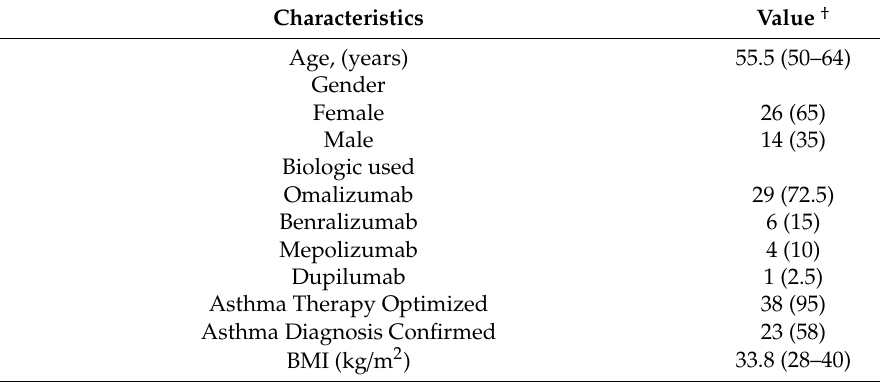
Table 1. Patient